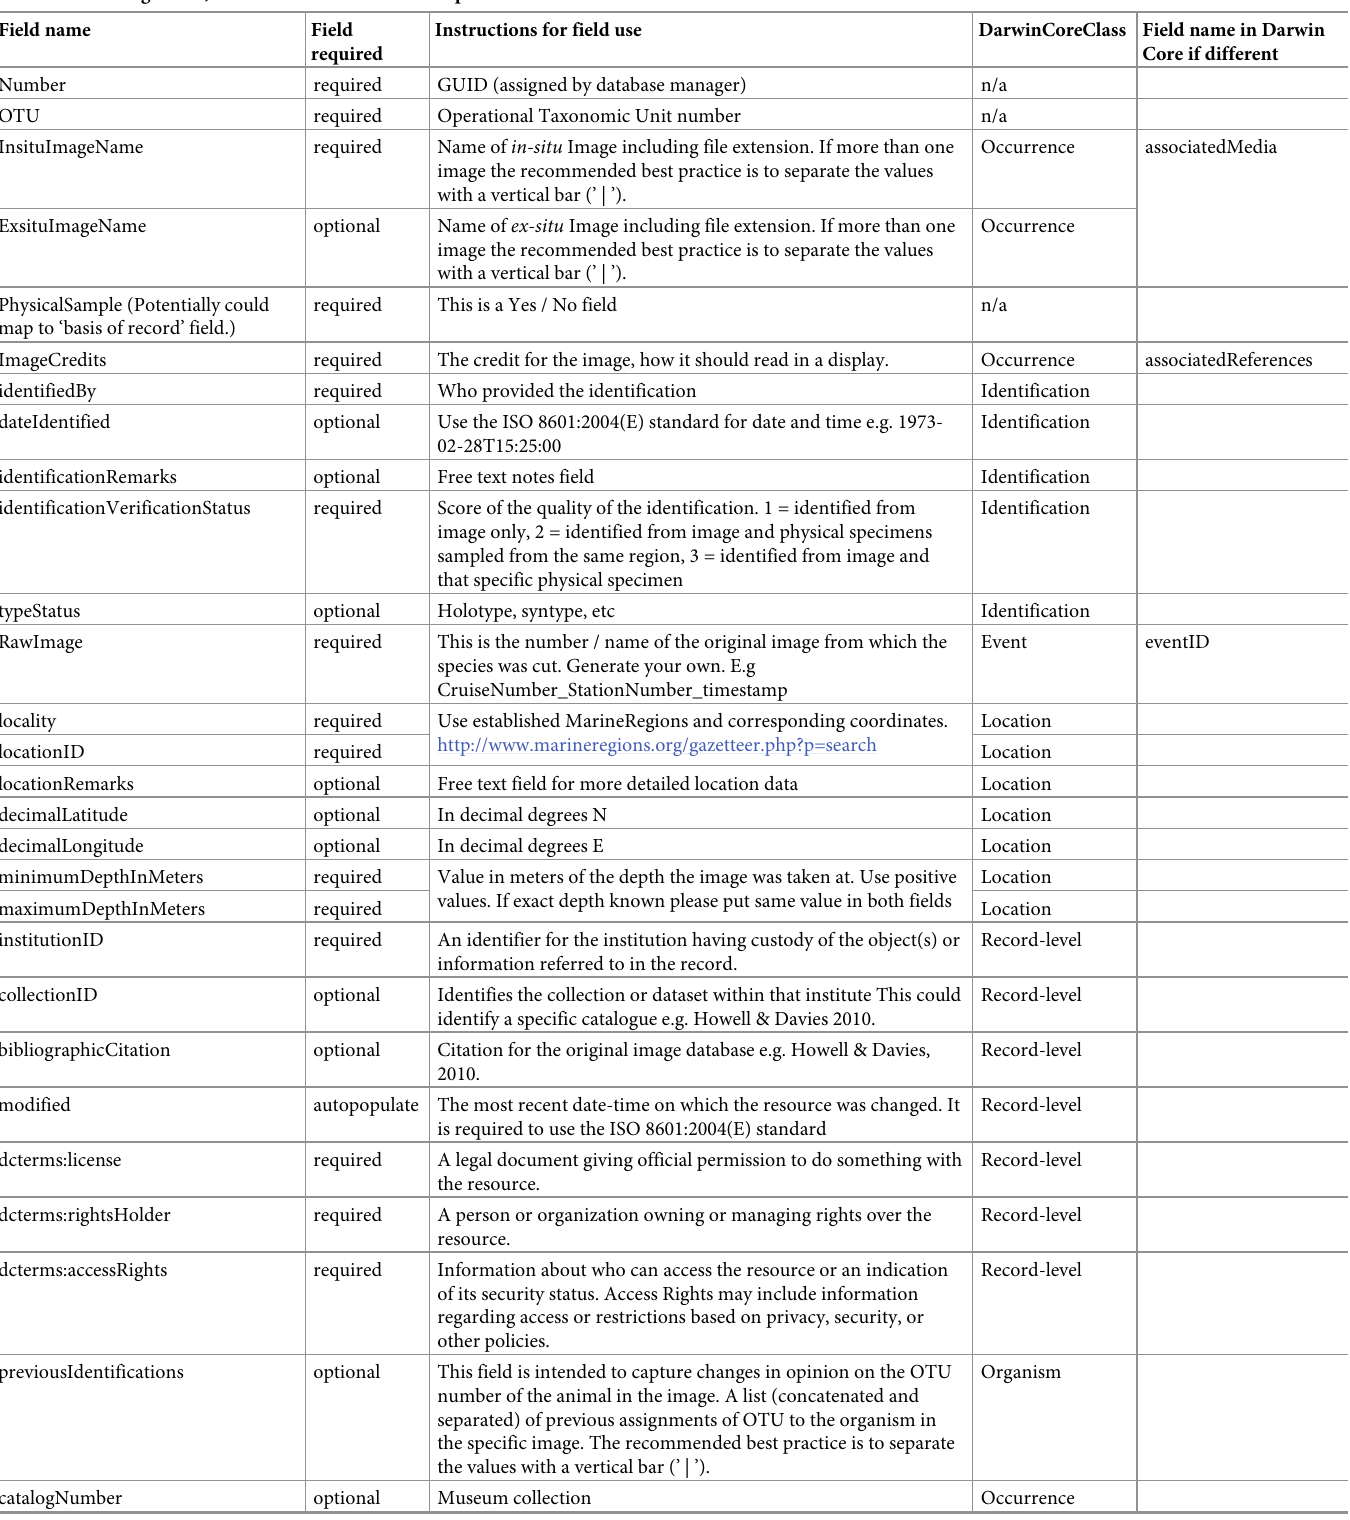
Table 3. The image table, one of two tables that make up the final